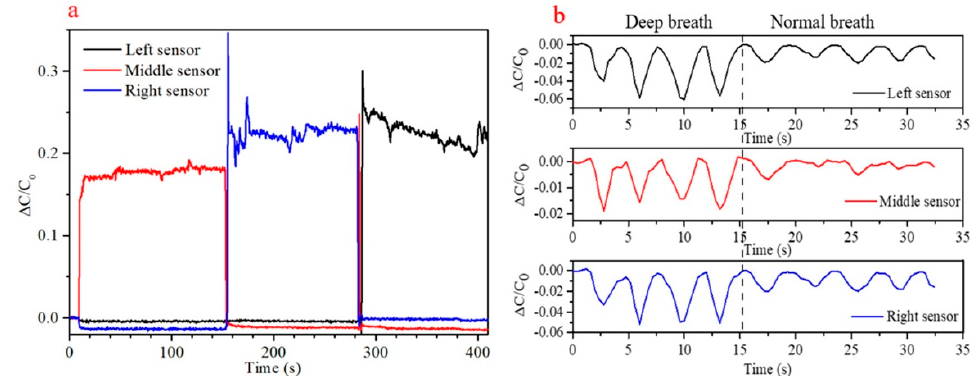
Figure 11. ( a ) Monitoring of head position with laterally separated sensors embedded under a pillow, as the head is moved from the center to the right hand side of the pillow, and then to the left. ( b ) Deep and normal breaths monitored with pad mounted sensors, laterally spaced.